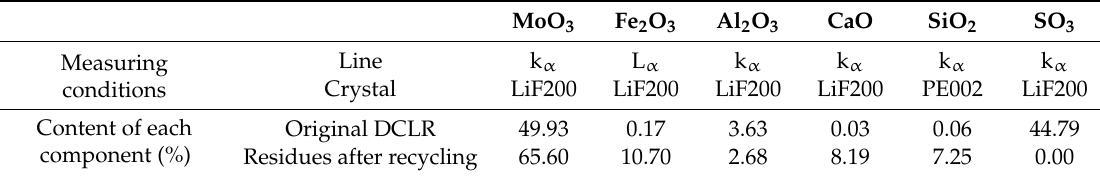
Table 1. Composition of the original DCLR and the residues after recycling.